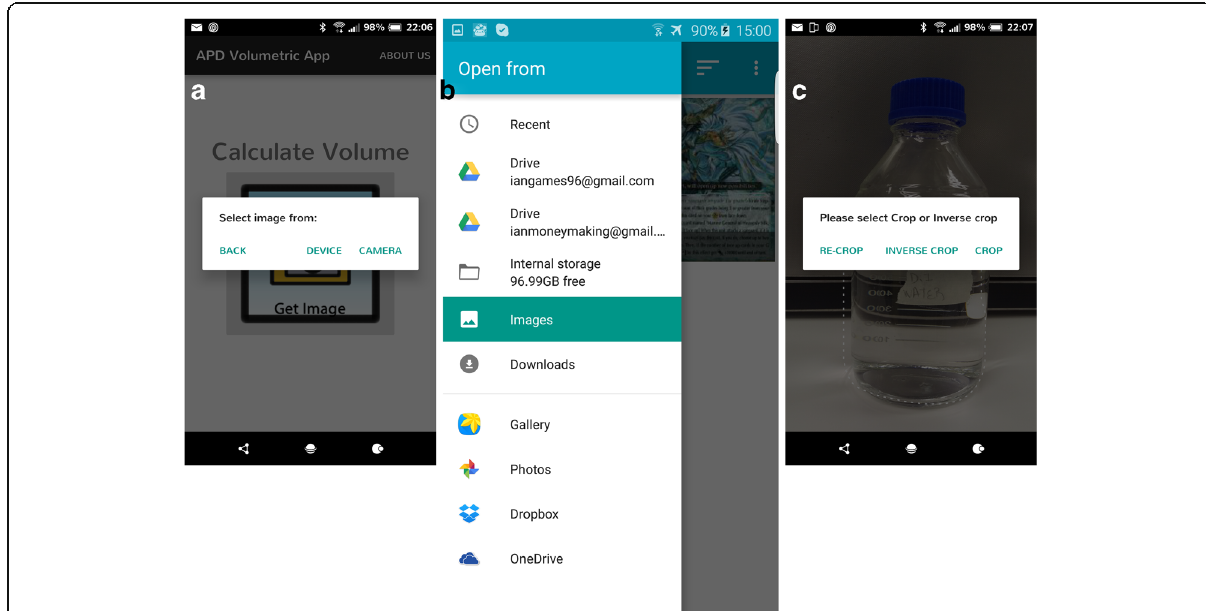
Fig. 1 Starting APD Volumetric App. a Choice of loading the picture from the device or to capture a new image directly from the camera. b Loading of the desired image from the phone, and also from Cloud storage apps. c Loaded image for processing